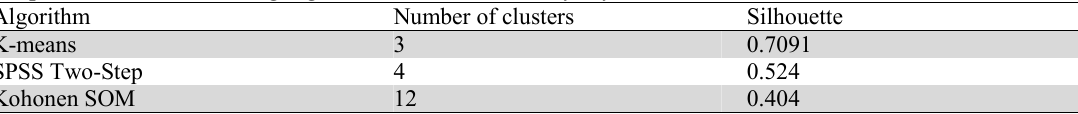
Comparison of the clustering algorithms for customer loyalty Algorithm Number of clusters